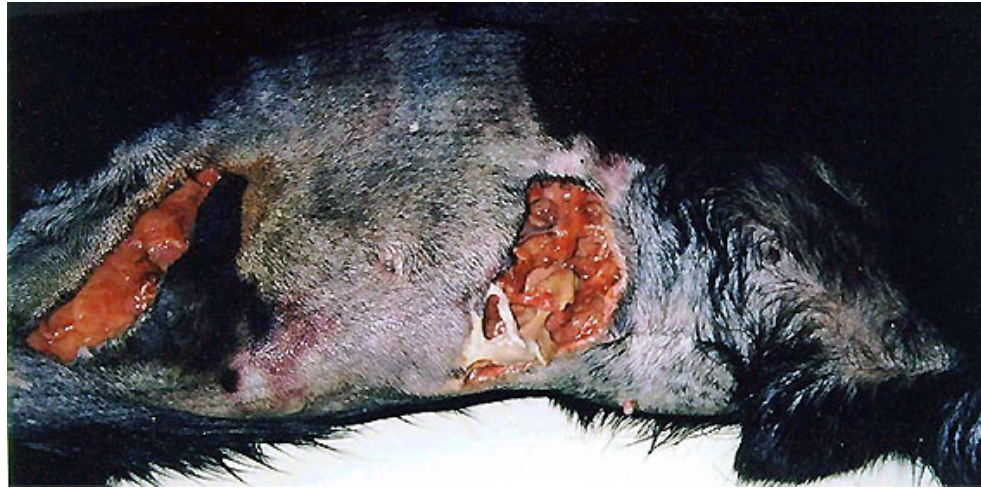
Figure 4. Tissue necrosis in the left lateral region of a dog twelve days after Bothrops